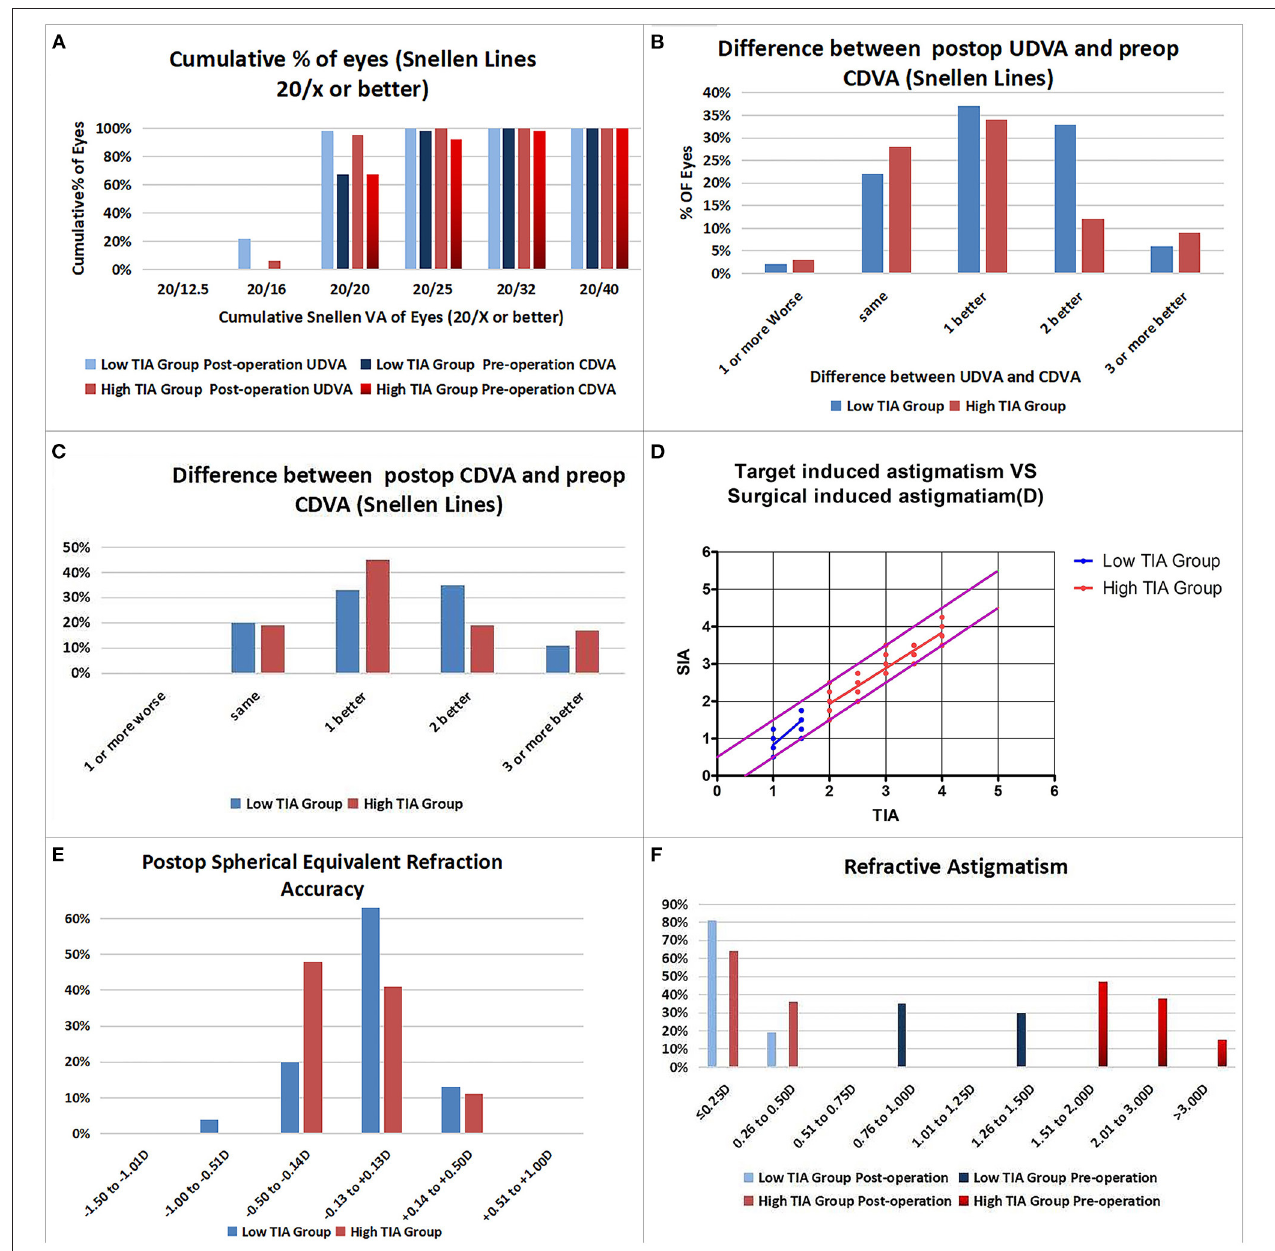
FIGURE 2 | Refractive outcomes in the low- and high-target-induced astigmatism (TIA) groups. (A) Cumulative percentage of eyes attaining specified levels of UDVA; (B) Postoperative vs. preoperative UDVA; (C) Change in CDVA; (D) TIA plotted vs. surgical-induced astigmatism at the last follow-up; (E) Distribution of postoperative spherical equivalent refraction; (F) Distribution of preoperative and postoperative astigmatism amplitudes.